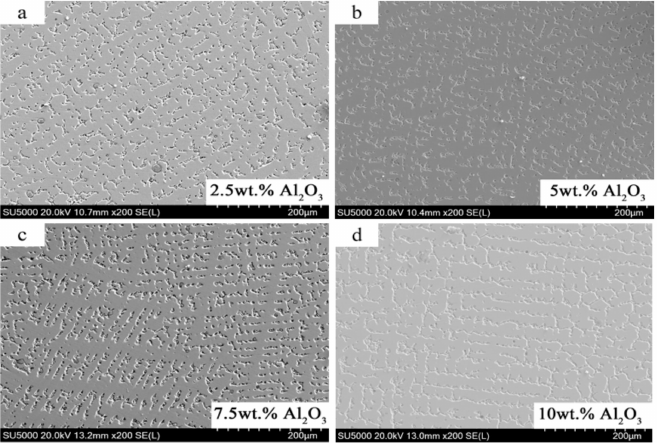
Figure 7. SEM micrographs of Al 2 O 3 molded parts. ( a ) Microstructure of 2.5% Al 2 O 3 alloy; ( b ) microstructure of 5% Al 2 O 3 alloy; ( c ) microstructure of 7.5% Al 2 O 3 alloy; ( d ) microstructure of 10% Al 2 O 3 alloy.